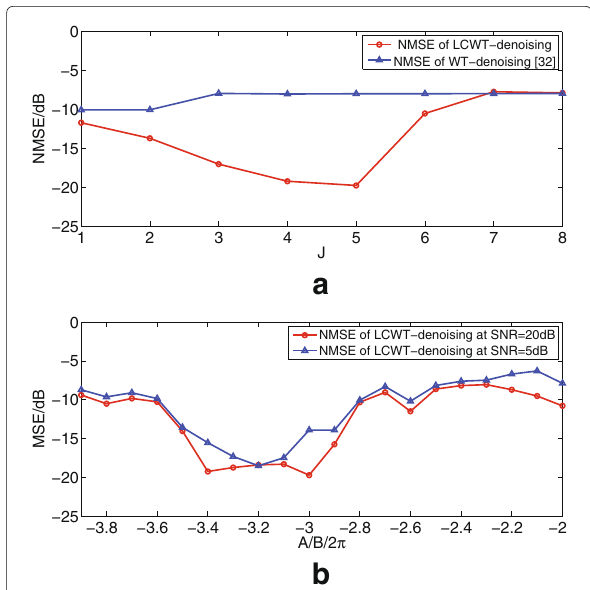
Fig. 10 Choosing the level and matched-parameter of the LCWT. a Performance of LCWT-based denoising and WT-based denoising [32] in different decomposition level J with SNR = 20 dB and M = ( − 6 π ,1,0, − 1 / 6 π) . b NMSE of LCWT-based denoising at SNR = 20 dB and SNR = 5 dB with level J = 5